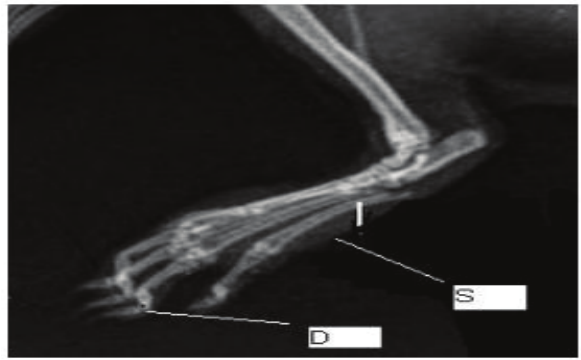
Fig-2: Group 2 Disease control shows swelling(S) of hind paw and deformity(D) of interphalangeal joints.